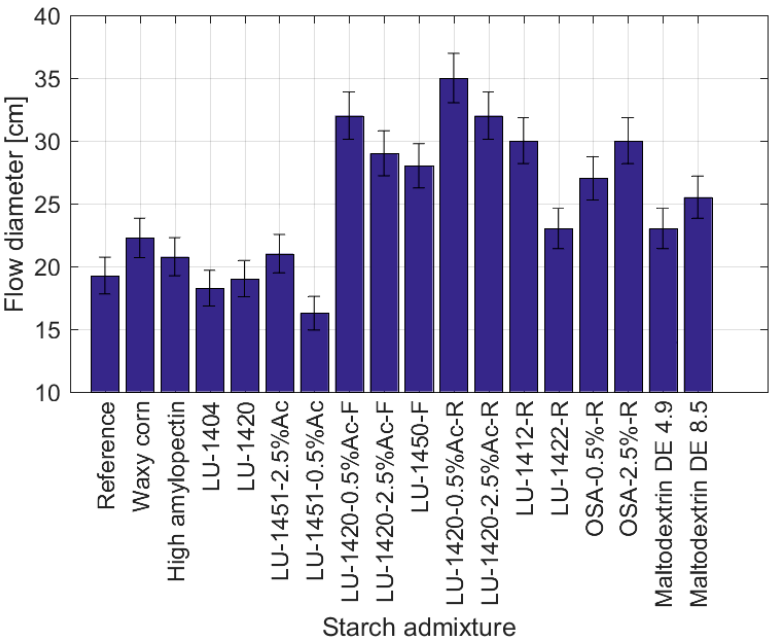
Figure 1. Correlation of the flow diameters of cement mortars with the type of starch admixture